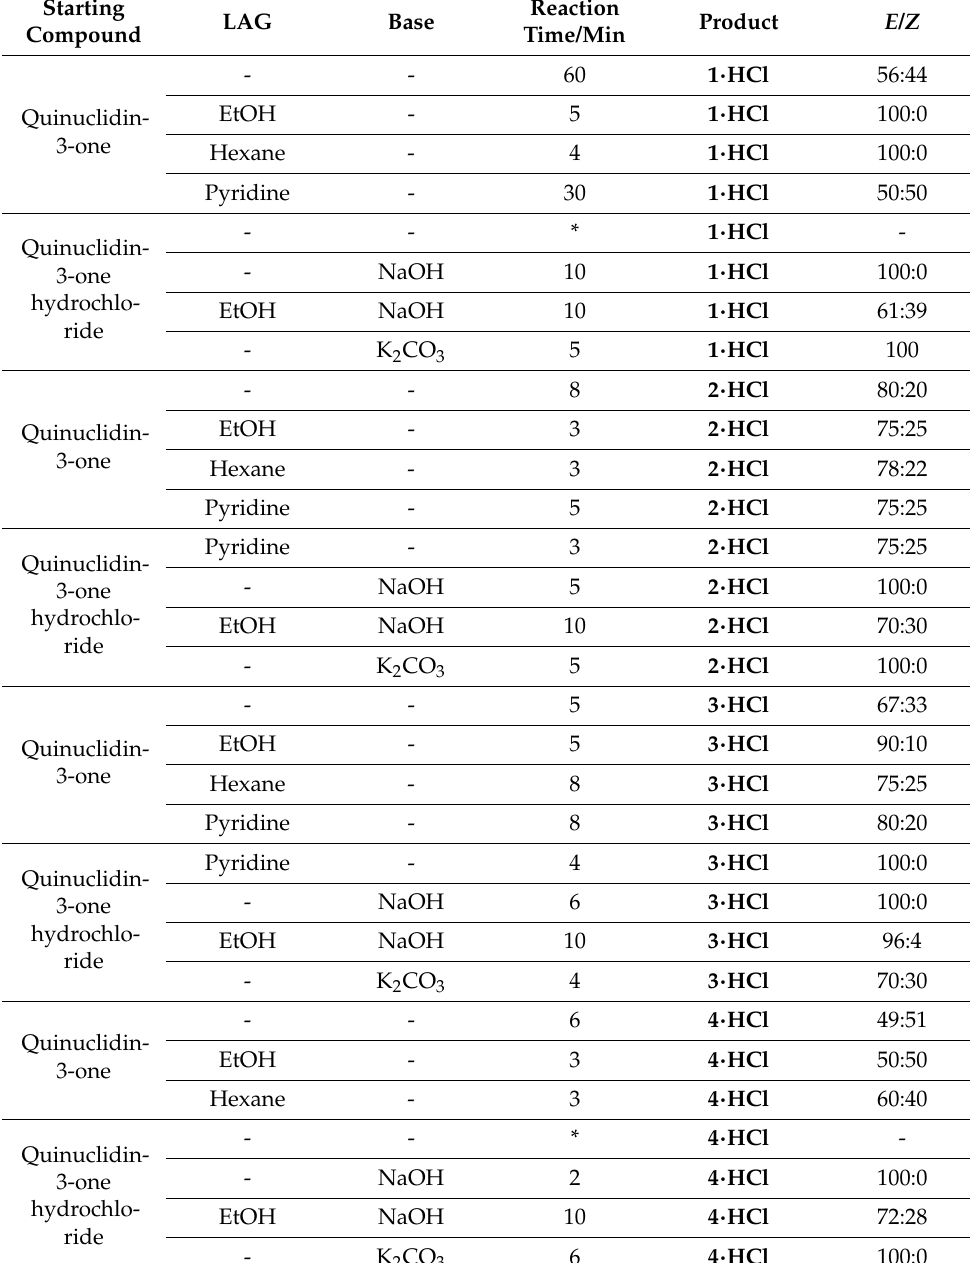
Table 2. Reaction conditions for mechanochemical synthesis (Method B) of compounds 1 · HCl – 4 · HCl . E / Z ratio was determined by 1 H NMR